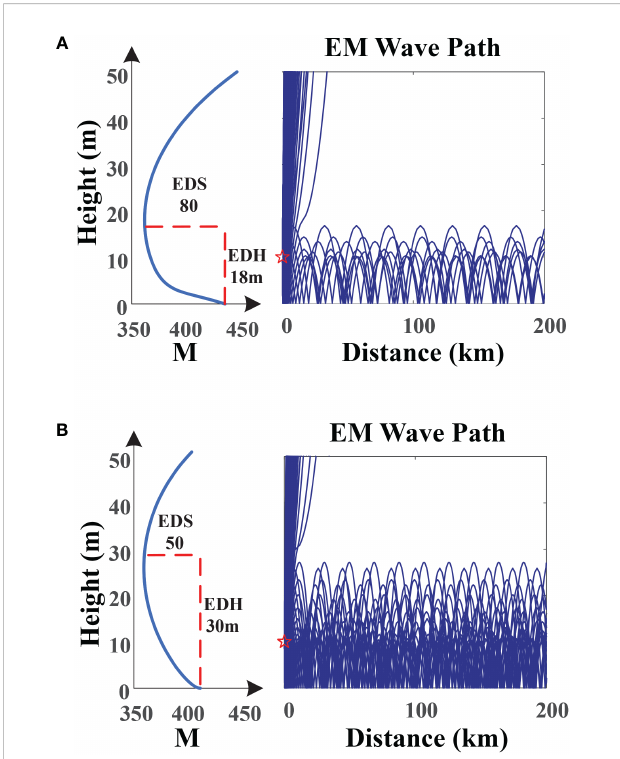
FIGURE 1 Differences in EM-wave transmission paths under different EDH